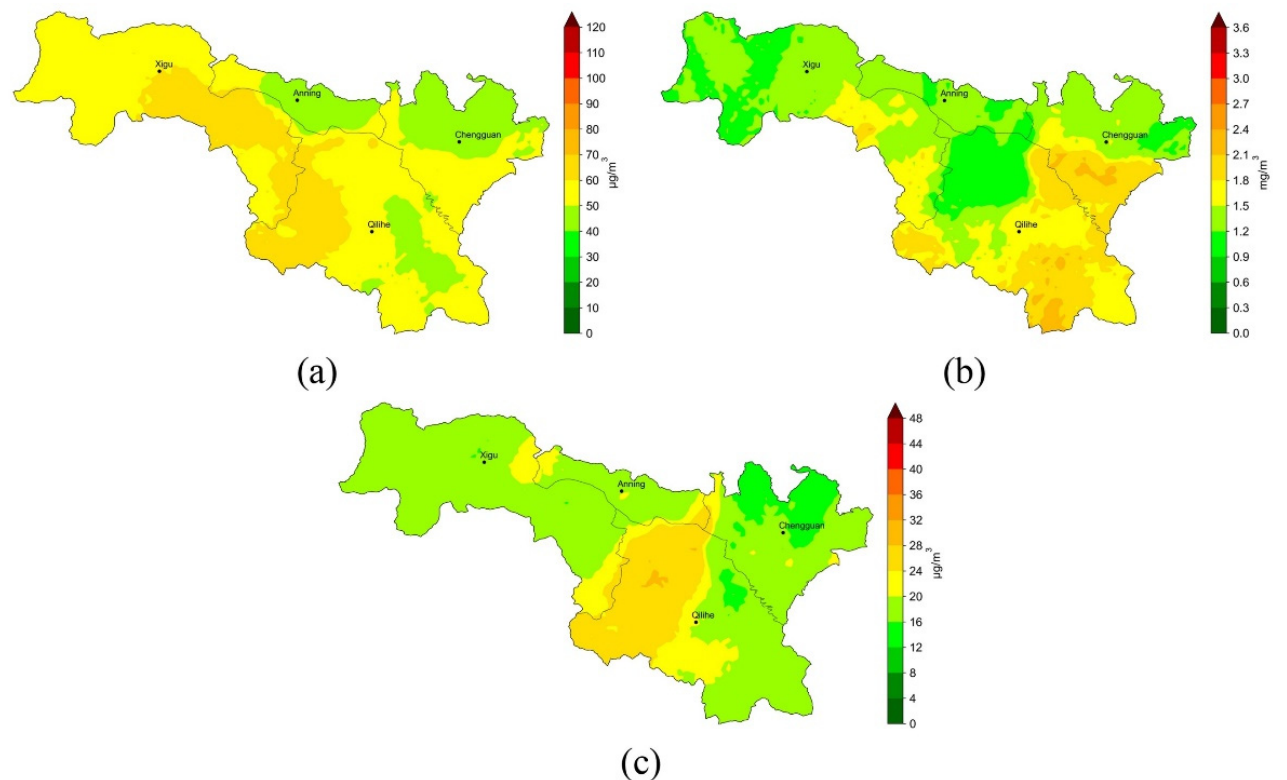
Figure 6. Average concentrations inferred by our model during 8–12 February 2022 in Lanzhou city: ( a ) PM 2.5 ; ( b ) CO; ( c ) SO 2.